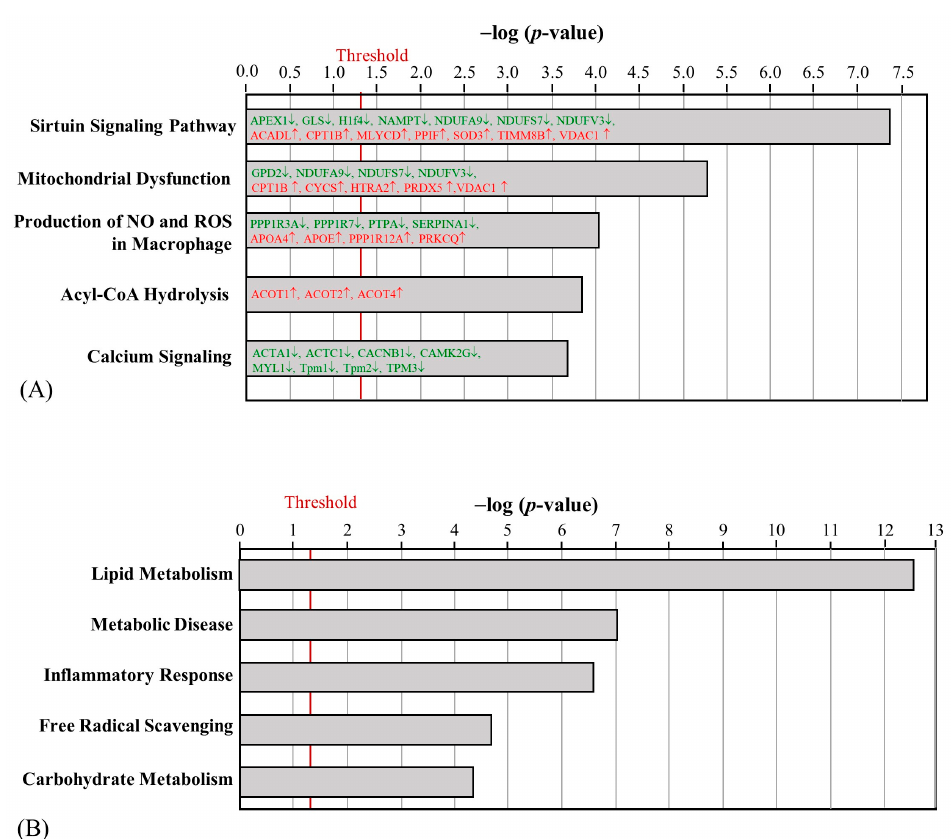
Figure 3. Effect of HFD on the canonical pathways ( A ) and biofunctions ( B ) regulated by skeletal muscle proteins between the NC and HFD groups. (The proteins with red letters were upregulated, whereas those with green letters were downregulated).